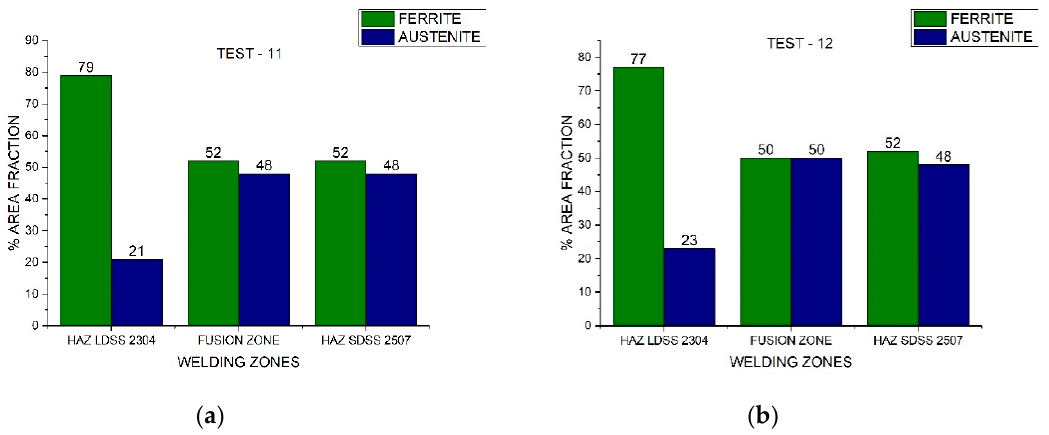
Figure 13. Area fraction through the distinct welded zones: ( a ) Test #11 and ( b ) Test #12.